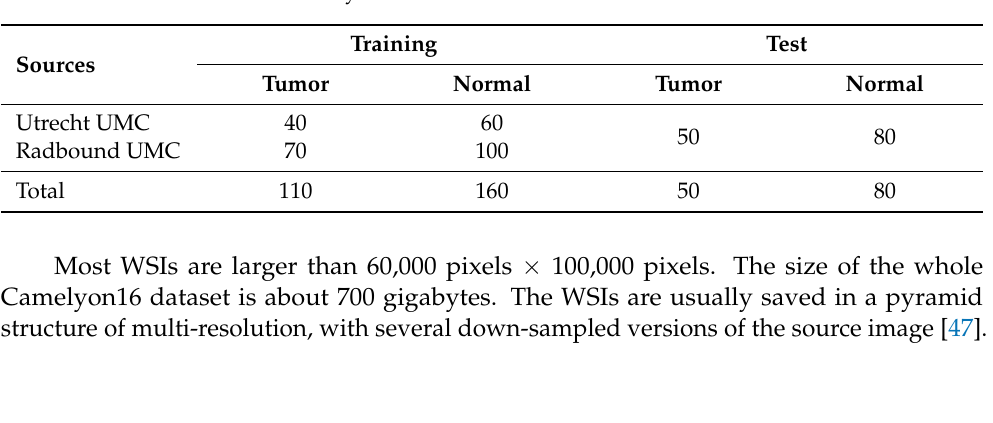
Table 1. The statistics of the Camelyon16